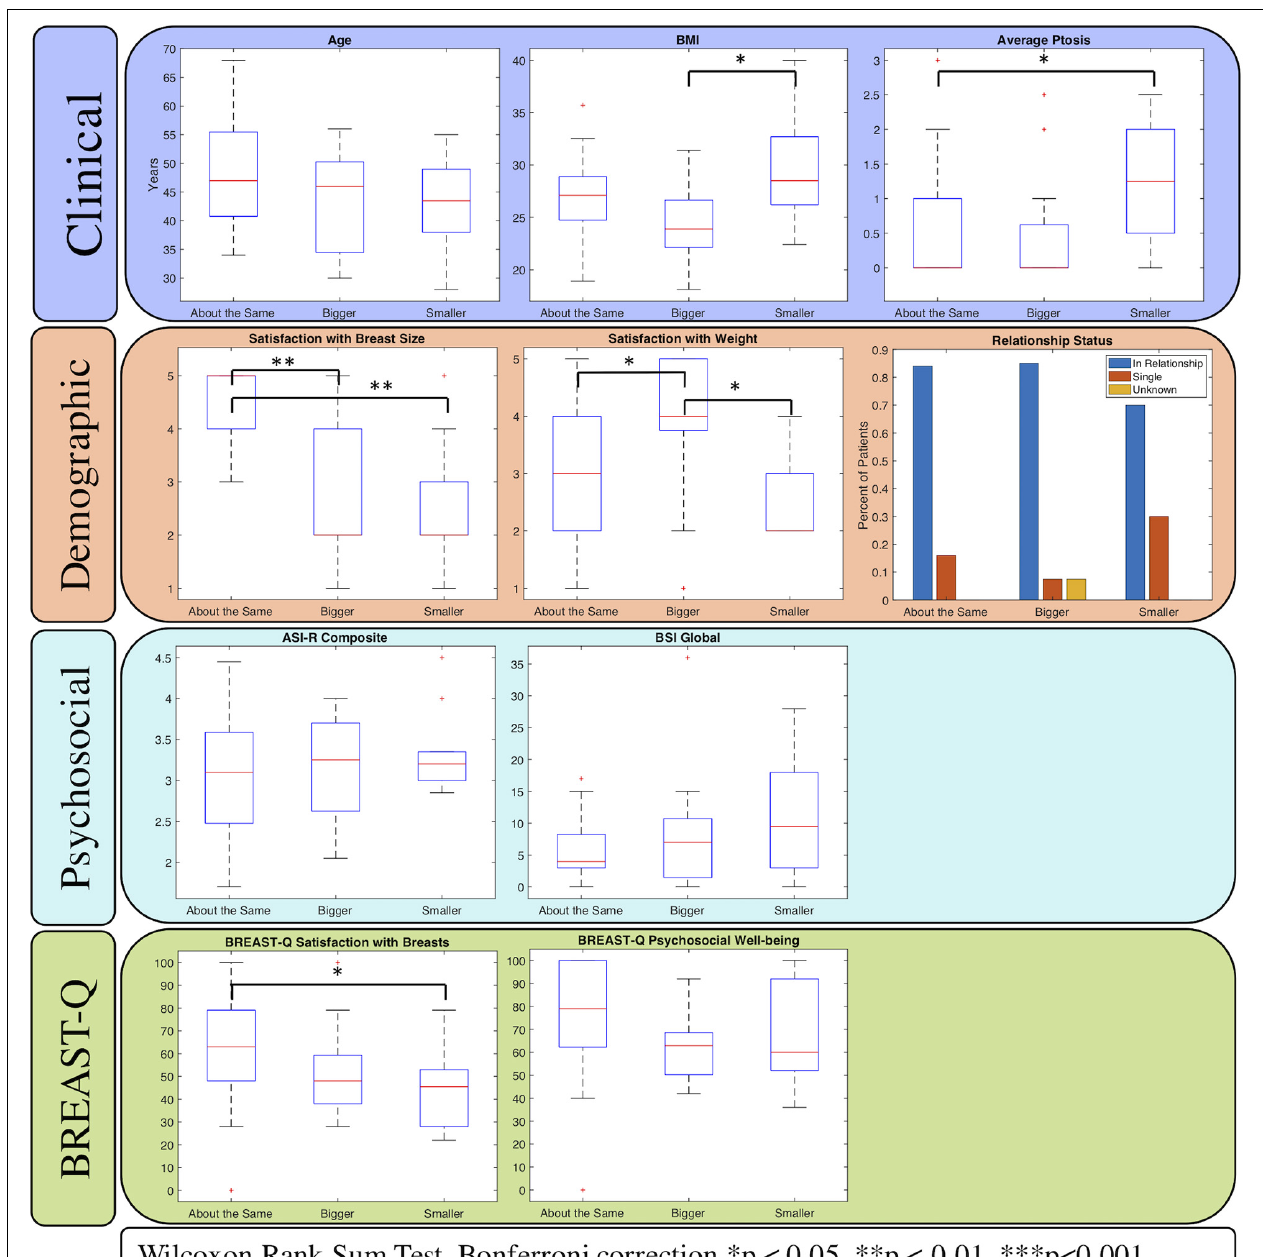
FIGURE 2 | Relationships between patients grouped by their preferences for change in breast size with potential covariates. Four categories of variables were selected as potential covariates: clinical, demographic, psychosocial, and the BREAST-Q. Variables with significant differences amongst the groups are marked with asterisks. Average breast volume (Clinical variable) is depicted in Figure 1